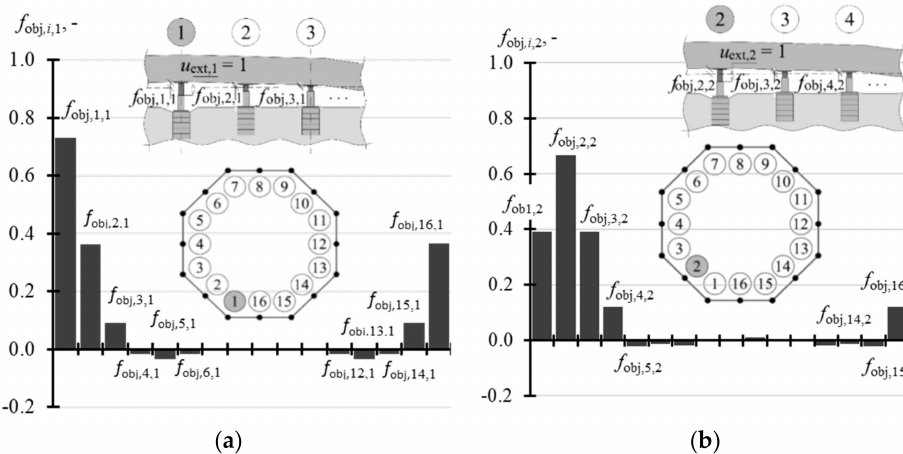
Figure 13. Values of elements in the matrix f obj : ( a ) elements f obj, i ,1 ; ( b ) elements f obj, i ,2 .